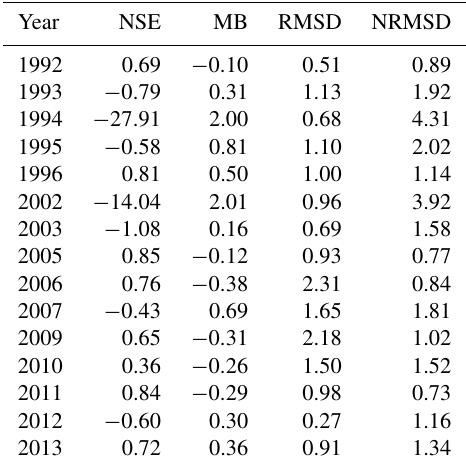
Table 4. Metrics used for model